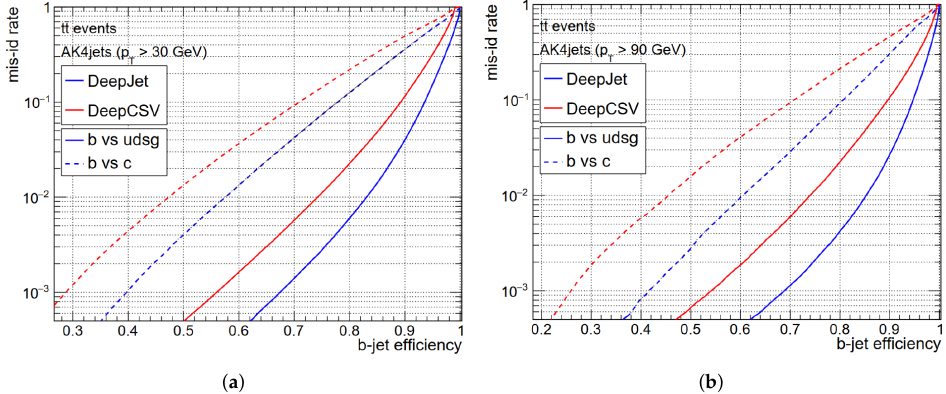
Figure 4. ROC curves of the DeepJet and DeepCSV b-tagging algorithms on t¯t events for which both top quark decay hadronically. In ( a ), p jet